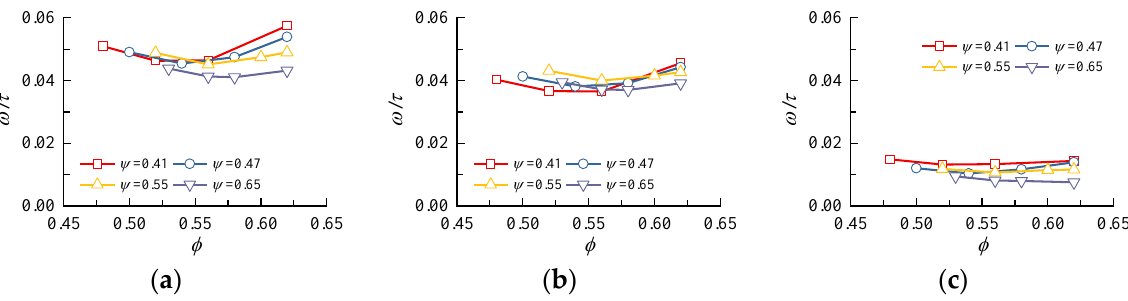
Figure 27. The comparison of stator loss between different design schemes: ( a ) total loss; ( b ) blade profile loss; ( c ) endwall loss.